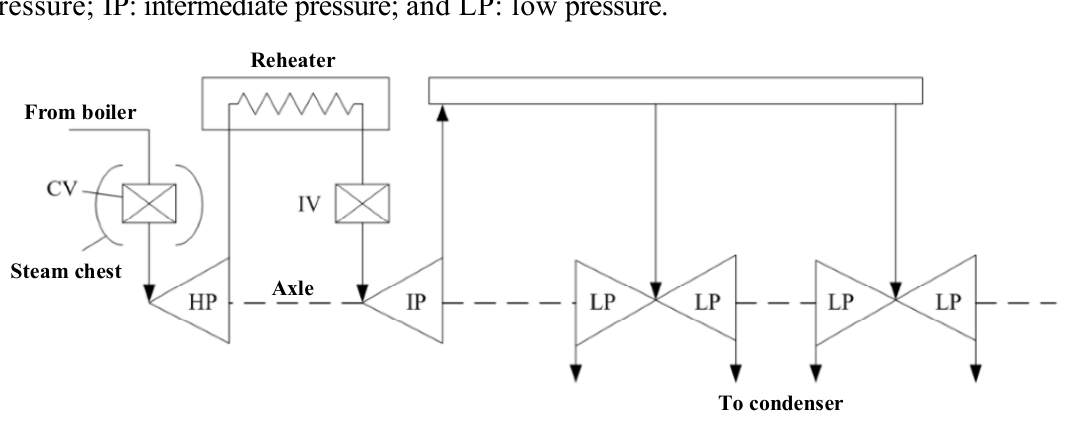
Figure 4. Structure diagram of traditional reheat condensing steam turbine. HP: high pressure; IP: intermediate pressure; and LP: low pressure.